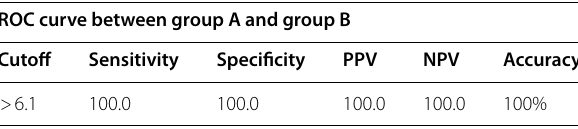
PPV positive predictive value, NPV negative predictive value